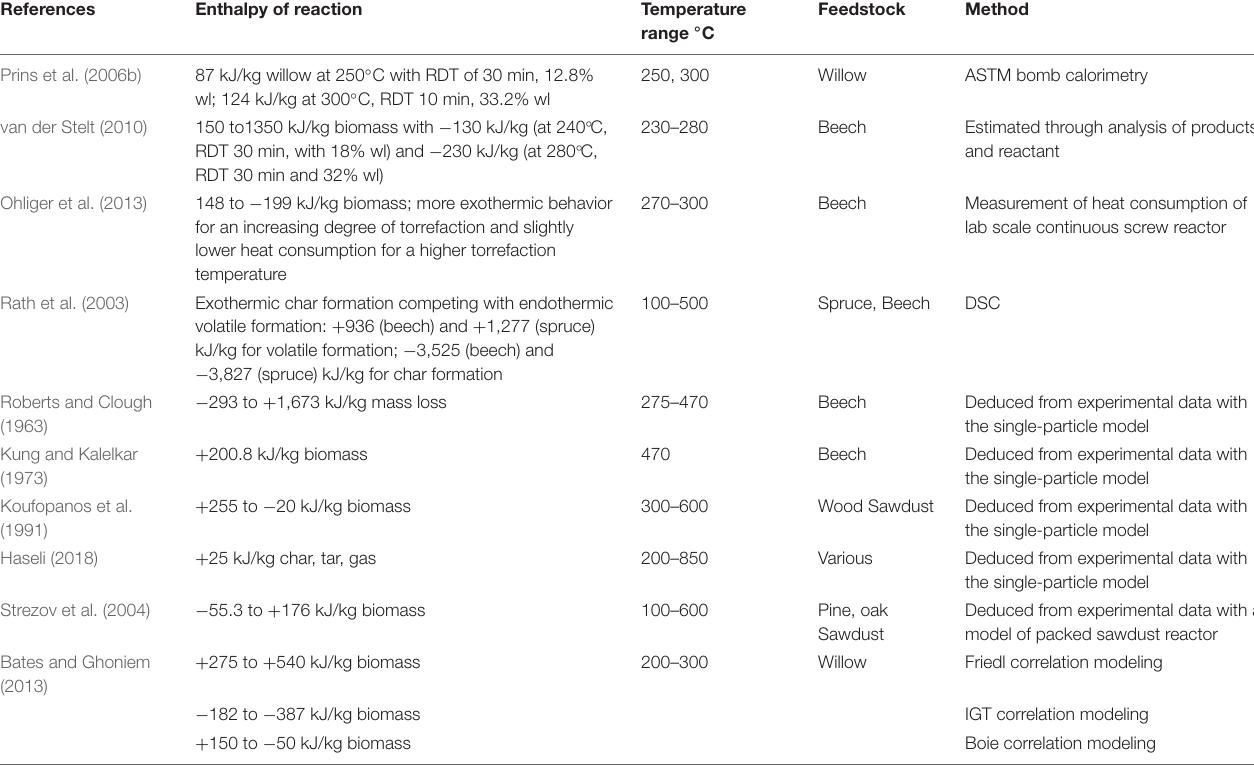
TABLE 1 | Experimentally measured or deduced enthalpy of reaction for torrefaction and pyrolysis.